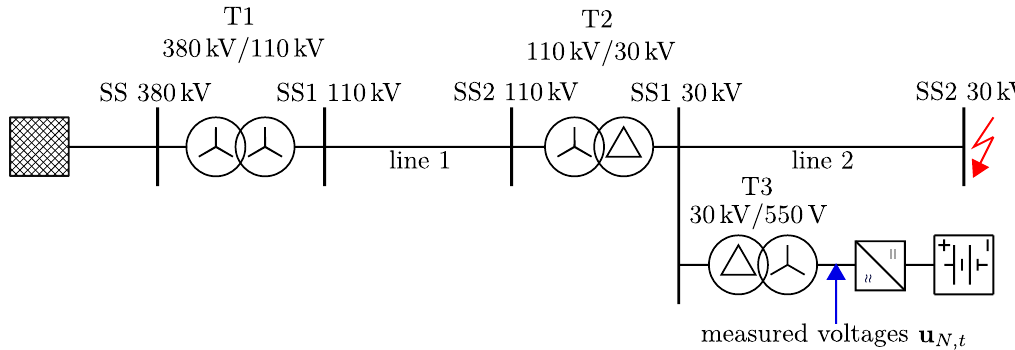
Figure 5. Single-line diagram of the short-circuit location from which measurements are used for